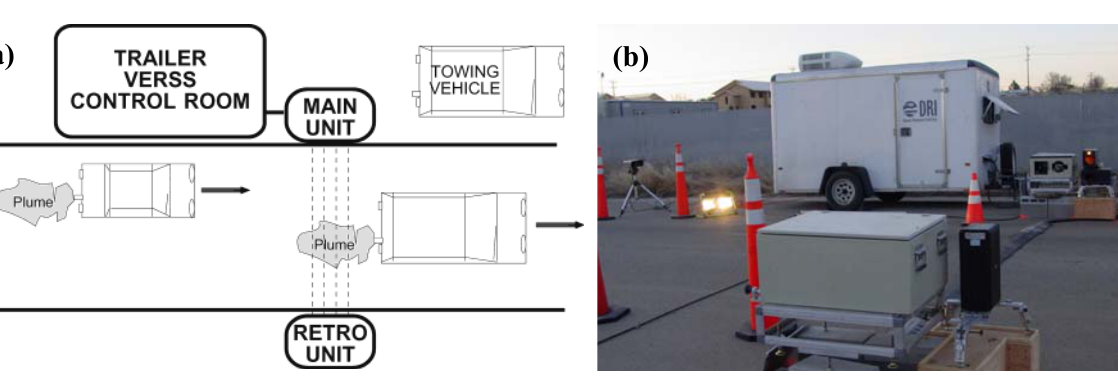
Figure 1. Diagram ( a ) and picture ( b ) of a typical field set-up system of the PM LiDAR and gaseous measurement systems. The main unit contains all the light sources and detectors, while the retro unit incorporates a set of mirrors and retro-reflectors. A trailer hosting the data acquisition and computer system is parked on the side of a single-lane road where the exhaust plume of vehicles passing by is intercepted by the light